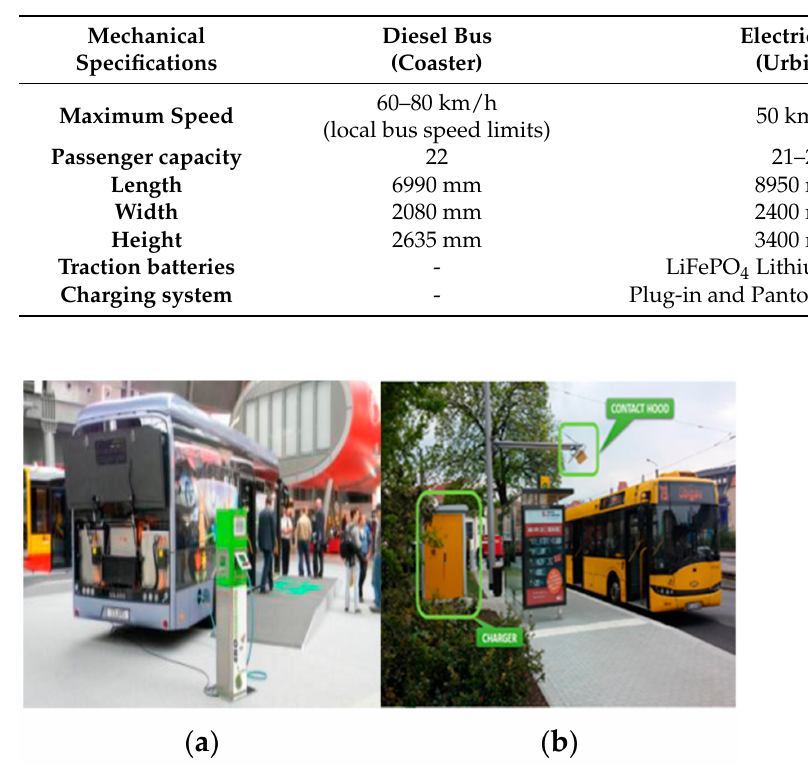
Figure 1. ( a ) Coaster Diesel, and ( b ) Urbino Electric Buses. Table 1. Specifications of the buses considered.